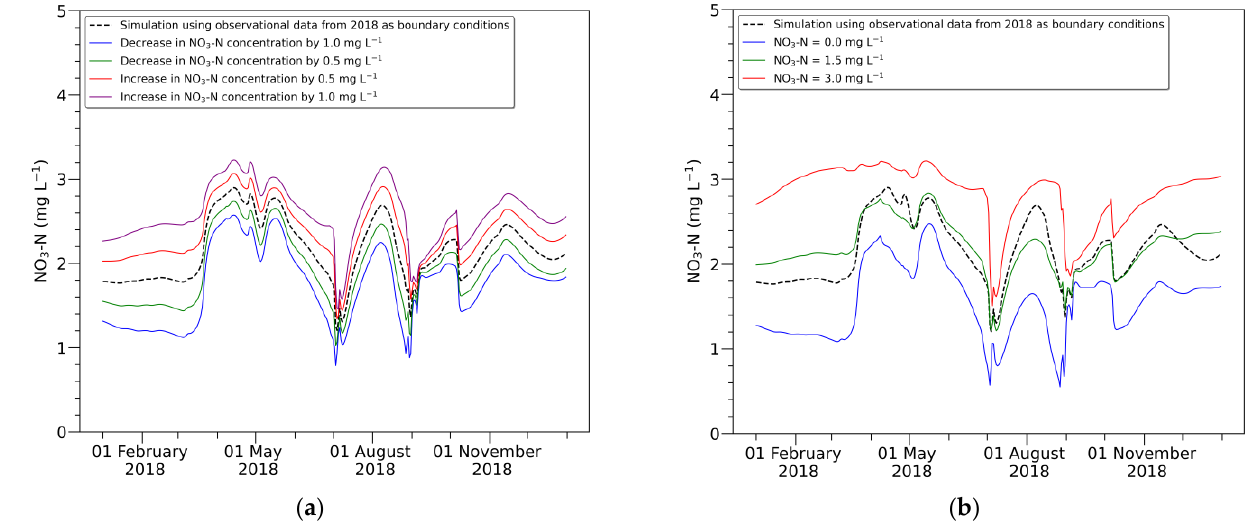
( b ) Figure 12. Changes in the NO 3 -N concentration in cross section 416 caused by variations in water temperature at the upstream boundary. The black graphs show results simulated using the obser- vational data from 2018 as boundary conditions. ( a ) Changes in the NO 3 -N concentration by a de- crease or increase in water temperature (Scenarios 43 – 45); ( b ) changes in the NO 3 -N concentration by constant water temperature (Scenarios 46 – 48). The simulation results under Scenarios 49 – 55 demonstrated that a marked variation